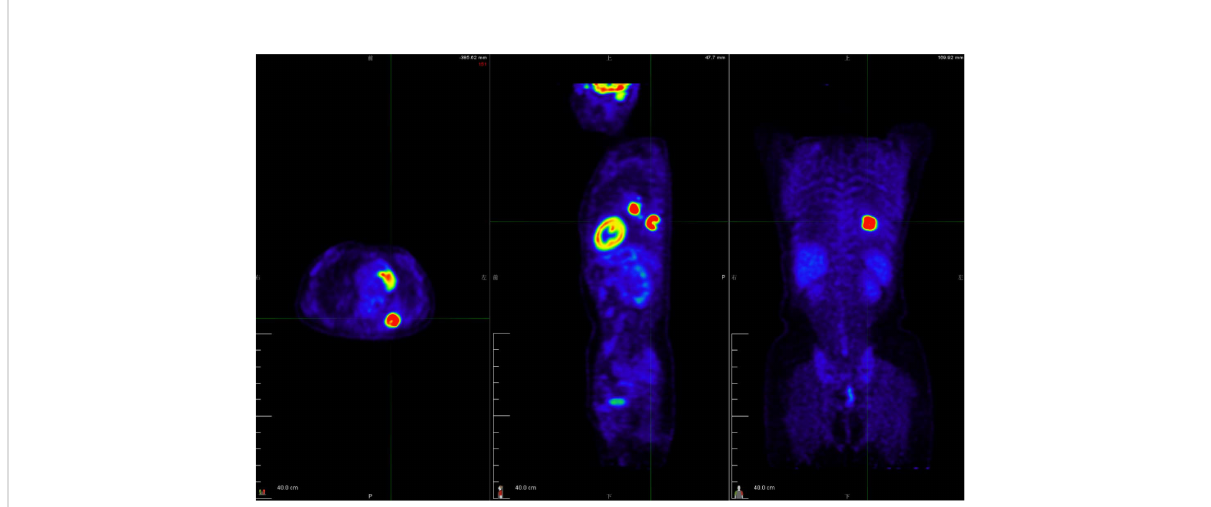
FIGURE 2 The 18F-FDG PET/CT examination was performed to evaluate the patient ’ s tumor stage. The 18-FDG PET/CT revealed strong 18-FDG uptake in the left lung mass, as well as the left hilar and subcarinal lymph node, measuring up to 2.5 cm and 2.2 cm in short diameters, respectively, but there was no evidence of distant metastasis. See Supplementary Material for a dynamic 3D